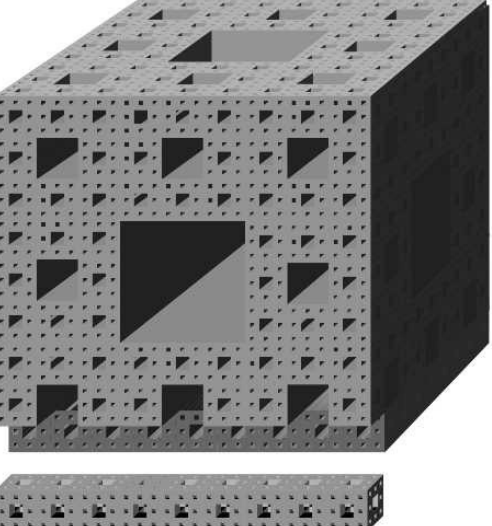
Figure 1. Fourth iteration of classical Menger sponge with d Sierpinski carpet with d